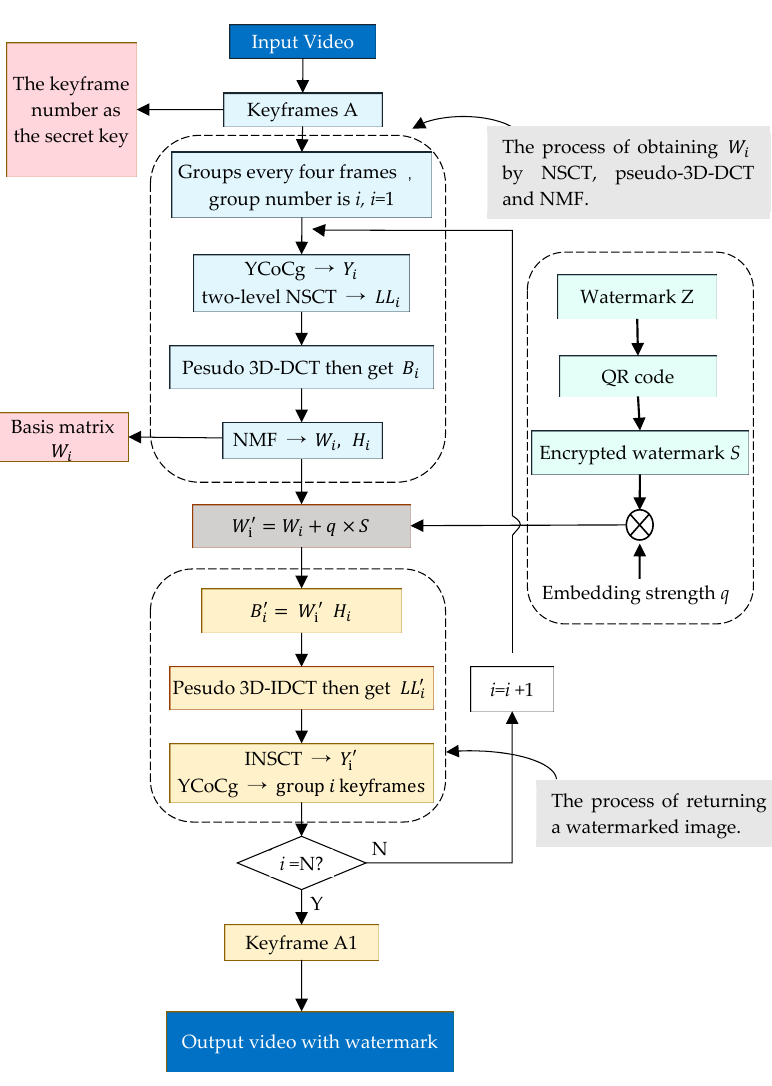
Figure 3. Video watermark embedding algorithm framework flowchart. Figure 4 is an example of the video watermark embedding algorithm of the video Foreman. Four images are obtained as a keyframes group. Both the process of obtaining 𝑊 (cid:3036) by NSCT, pseudo 3D-DCT and NMF, and the process of returning a watermarked image, are operated. Finally, the watermarked video is produced, and the secret key and basis matrix are saved in the third party.